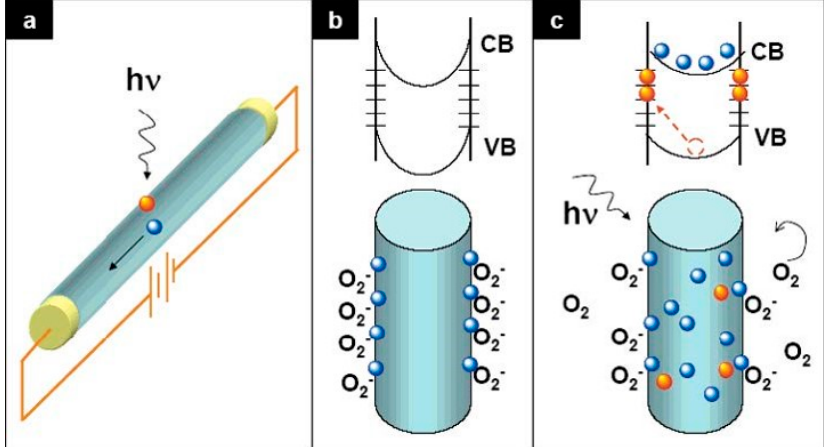
Figure 3. Influence of surface trap states on oxygen molecule adsorption, charge transfer, and band bending within a nanowire. ( a ) Photoexcitation increases nanowire free carrier density and conduction, which are reduced ( b ) by oxygen molecule adsorption, increased band bending, and reduced carrier density inside the wire. ( c ) Above band gap excitation of the O 2 —adsorbed wire reduces band bending as additional free carriers recombine with trapped surface charge and O 2 molecules desorb. With permission from [26]. Copyright 2007 American Chemical Society.